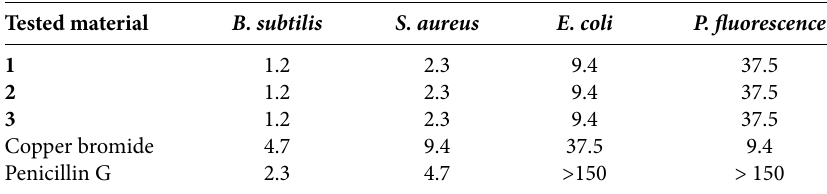
Table 4. Antibacterial activities of the complexes with minimum inhibitory concentrations (μg mL –1 ) Tested